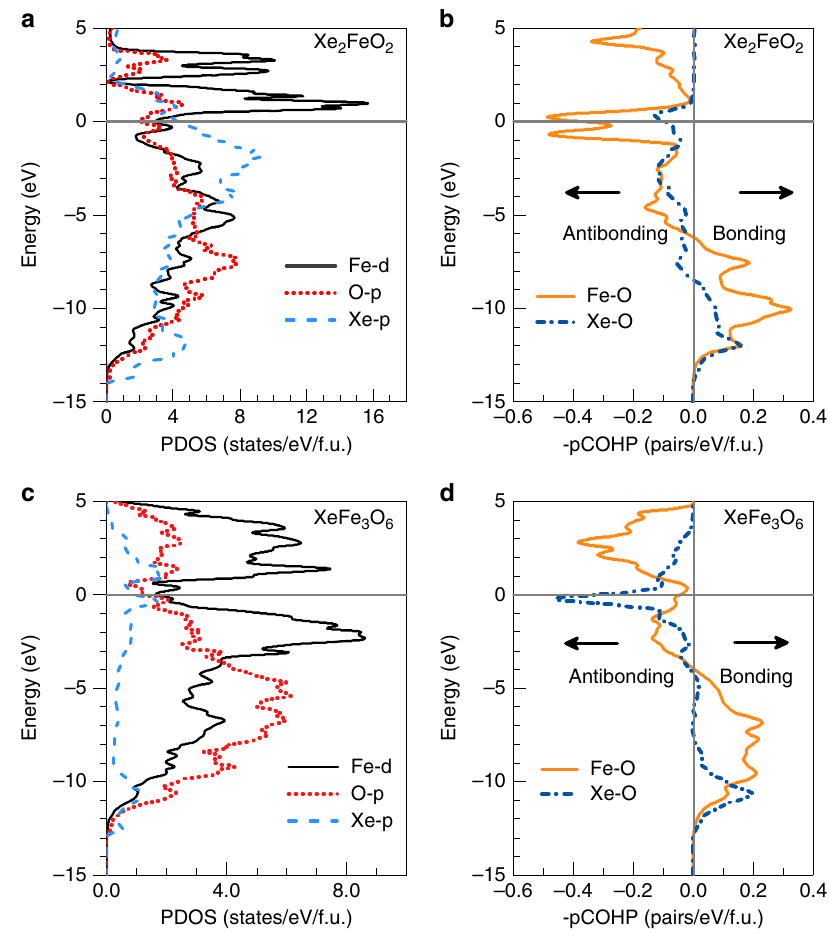
Fig. 2 Electronic properties of the two Xe-Fe oxides at 150GPa. a Projected density of states (PDOS) of Fe-d, O-p, and Xe-p orbitals in Xe 2 FeO 2 . b Projected crystal orbital Hamiltonian Population (-pCOHP) of the newly predicted Xe 2 FeO 2 compound. The values of -pCOHP >0 signify bonding states and the values of -pCOHP <0 signify antibonding states. c PDOS of Fe-d, O-p, and Xe-p orbitals in XeFe 3 O 6 . d -pCOHP of the newly predicted XeFe 3 O 6 compound. The Fermi energy is set to zero of the